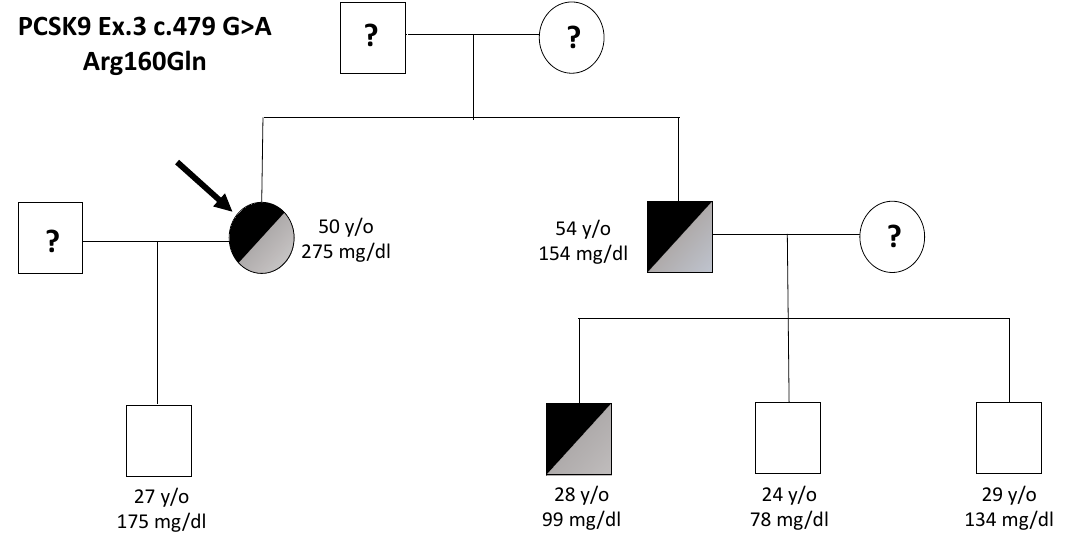
Figure 1. Family pedigree showing the carriers of the p.(Arg160Gln) PCSK9 variant. Half-blackened indicates heterozygous carriers of the p.(Arg160Gln) variant. The arrow represents the proband. Age (in years) and LDL-C (mg/dL) are given. “?” unknown. Table 1. Sex, age, lipid profiles and mutational status of proband and family members characterised during the study. TC, LDL-C, HDL-C and TG are expressed in mg/dL.